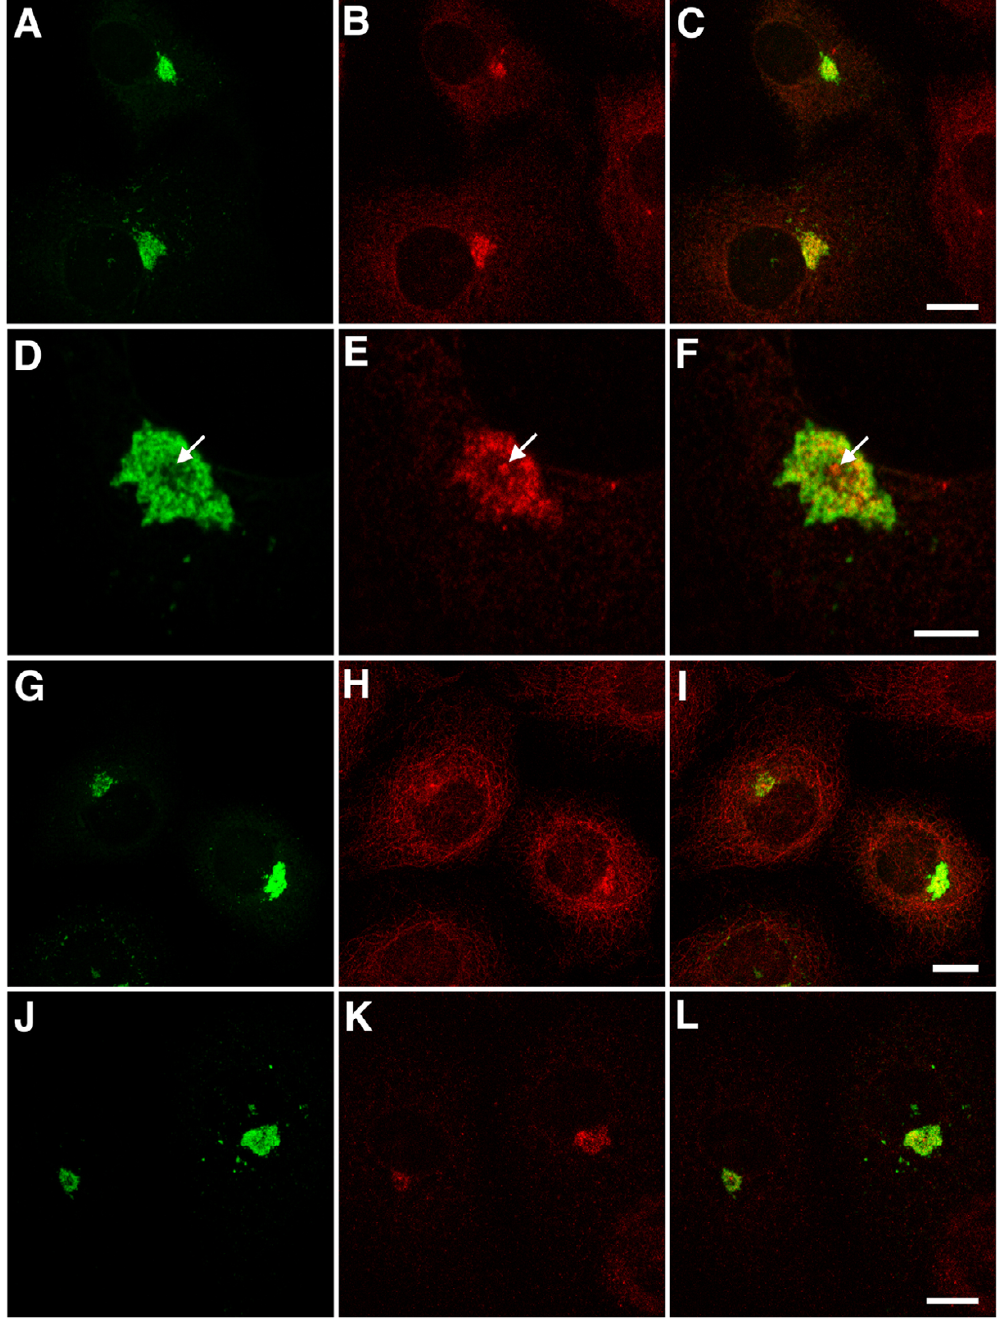
Figure 7 Dynein/dynactin subunits are present in EB1- ∆ N2-GFP aggresomes. Panels A-C. Cells expressing EB1- ∆ N2-GFP were fixed and co-immunostained for GFP (green, panel A) and p150glued (red, panel B). A merged image is shown in panel C. p150glued is seen in aggresomes. Bar = 10 µ m. Panels D-F. A single 0.365 µ m confocal section through a cell expressing EB1- ∆ N2-GFP. p150glued immunoreactivity in aggresomes (panel E) is heterogeneous but only seen in association with GFP immunoreactivity (panels D and F). Centrosomal immunostaining is also observed (arrow). Bar = 5 µ m. Panels G-L. Cells expressing EB1- ∆ N2- GFP were fixed and co-immunostained for GFP (green, panel G) and either CDIC (red, panel H) or p50dynamitin (red, panel K). Merged images are shown in panels I and K. Heterogeneous CDIC and p50dynamitin immunostaining is seen in aggresomes and at centrosomes. Bars = 10 µ m. Images in panels A-C and G-L are projections of confocal image